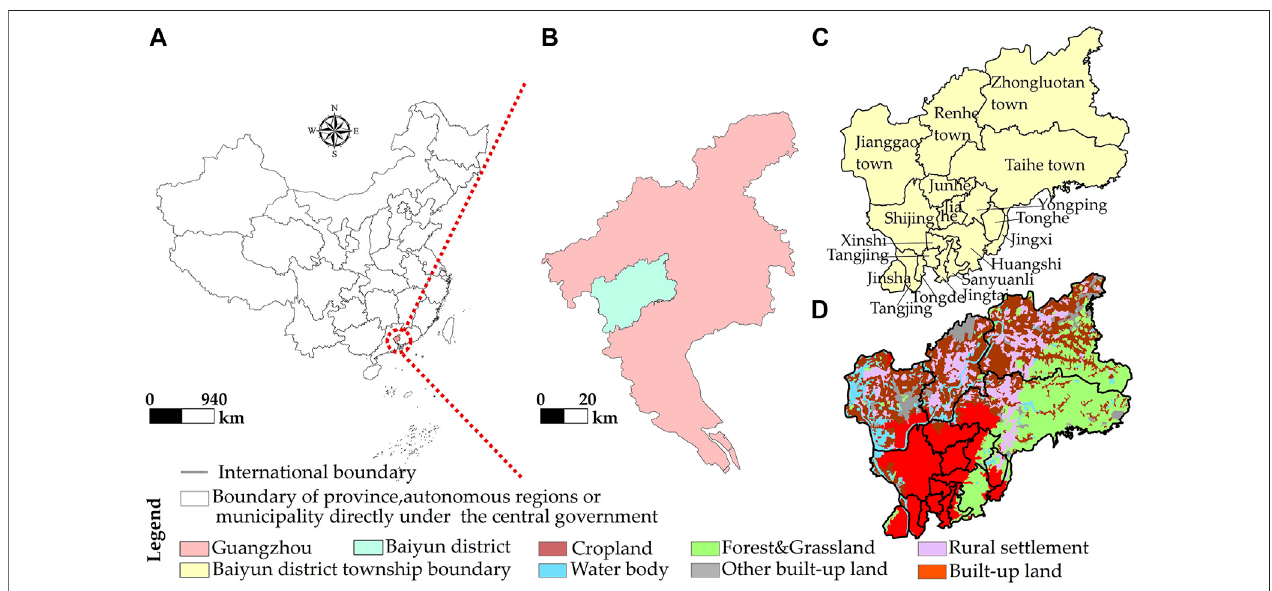
FIGURE 1 | The location of Baiyun, Guangzhou (A,B) , boundaries of each township (C) and spatial distribution of land use in 2020 (D) .